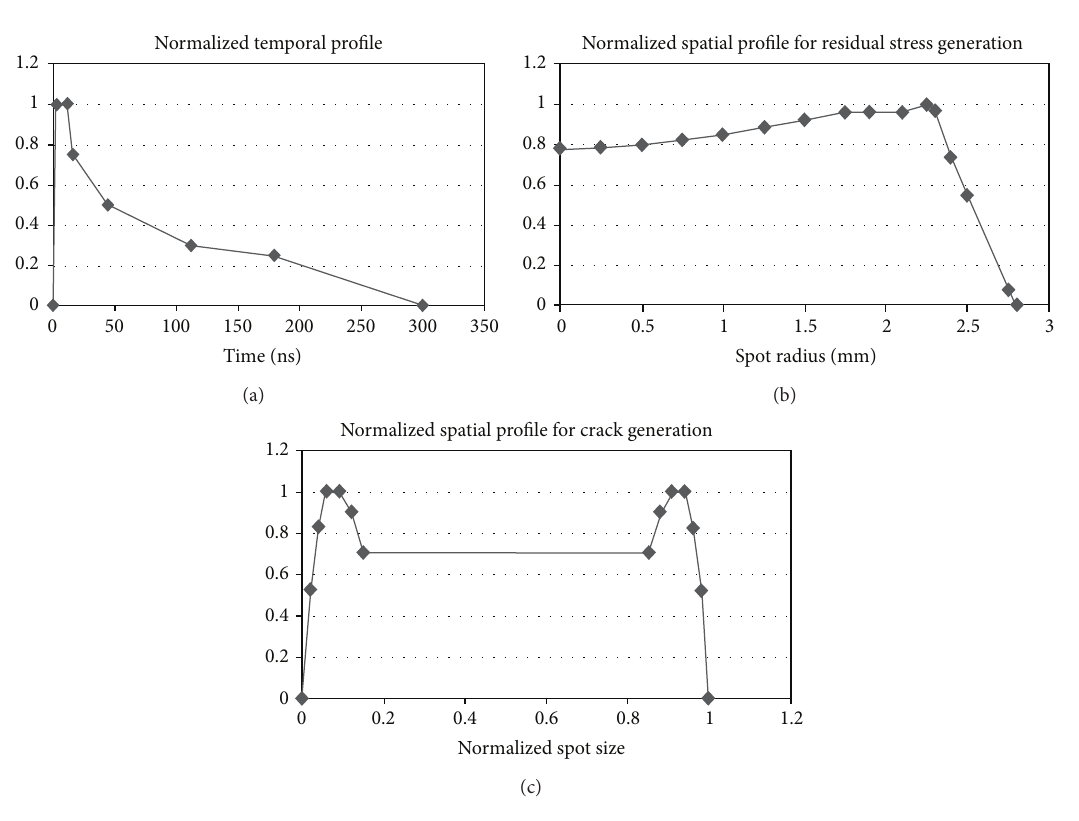
Figure 2: (a) The normalized temporal profile, (b) normalized spatial profile of the shock wave for residual stress generation, and (c) normalized spatial profile of the shock wave for crack